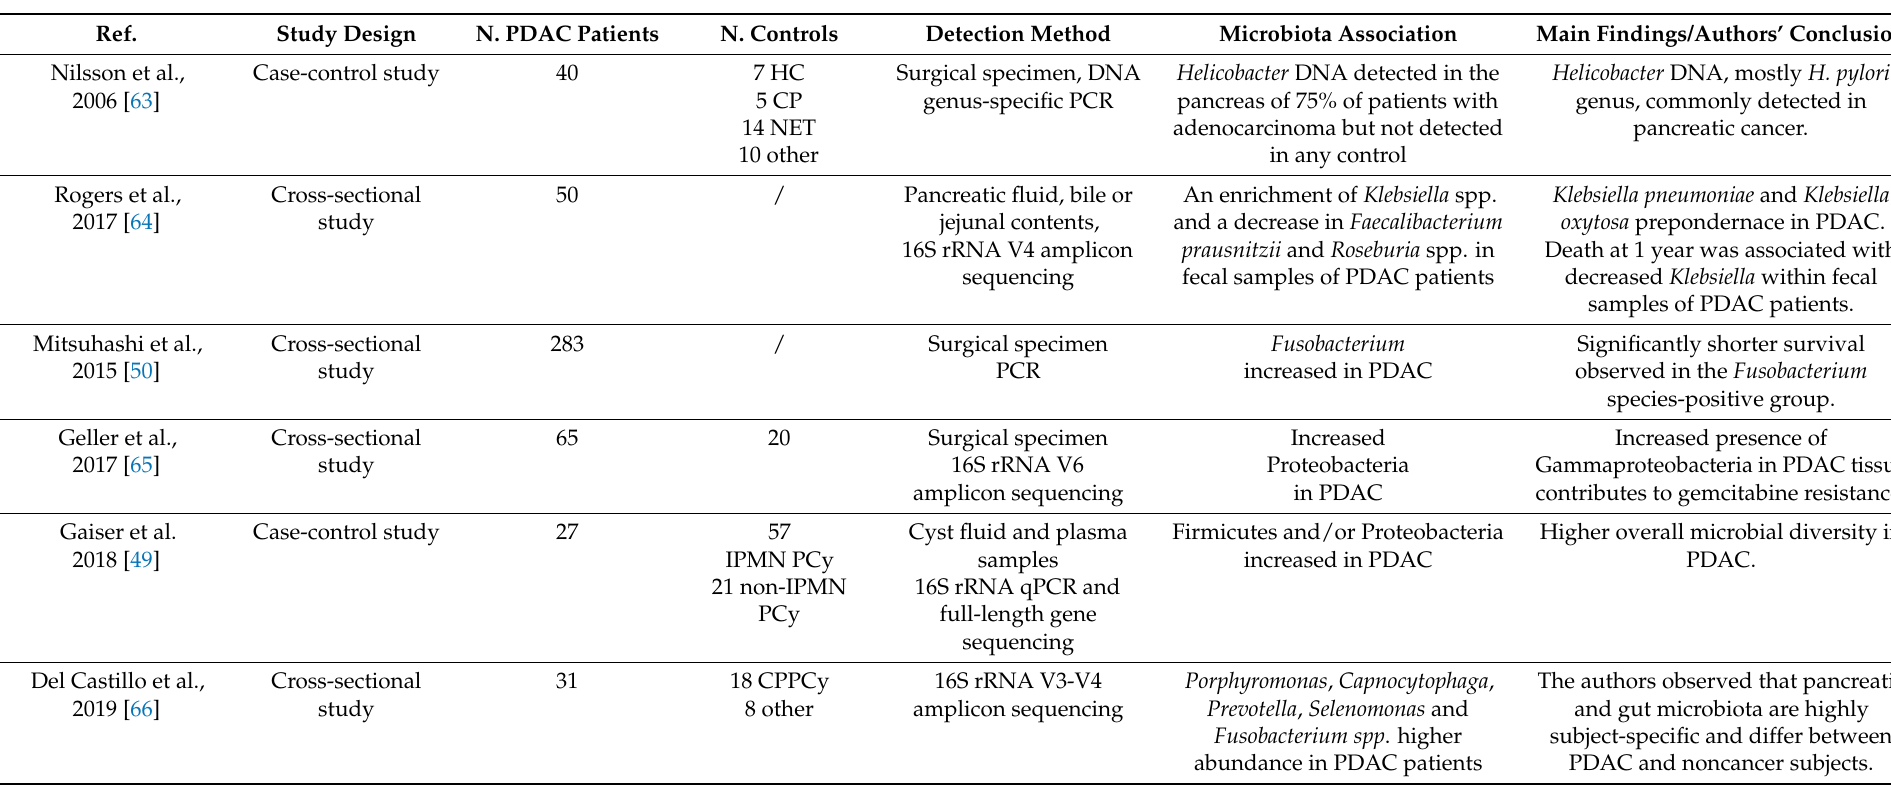
Table 2. Studies investigating PDAC intratumoral microbiota. Number of subjects (N); pancreatic ductal adenocarcinoma (PDAC); healthy control (HC); chronic pancreatitis (CP); pancreatic neuroendocrine tumor (NET); pancreatic cyst (PCy); intraductal papillary mucinous neoplasm (IPMN); long-term PDAC survivor (LTS); short-term PDAC survivor (STS).